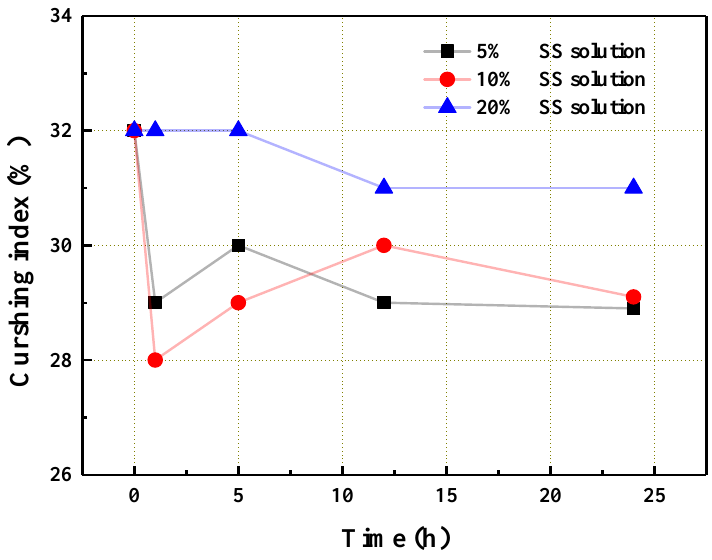
Figure 9. The crushing index of the coral aggregate that was treated with the SS solution.